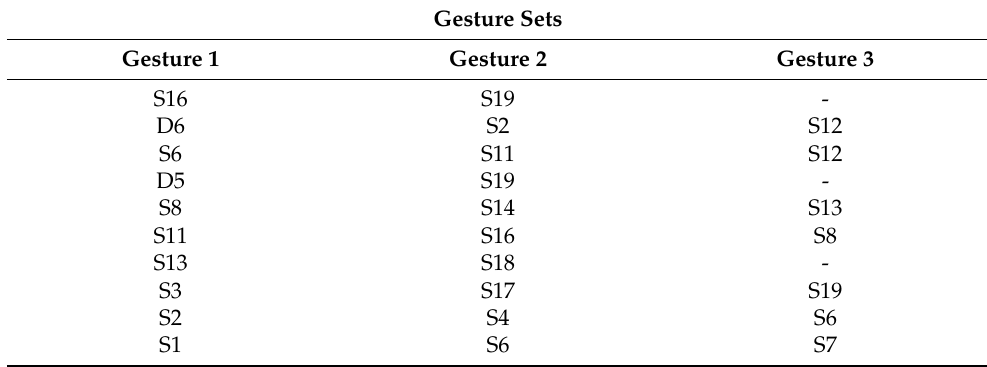
Table A1. Gesture Sets to be performed by users in evaluation phase 2. The corresponding gestures to the acronyms in the table can be found in Figure 6 of the